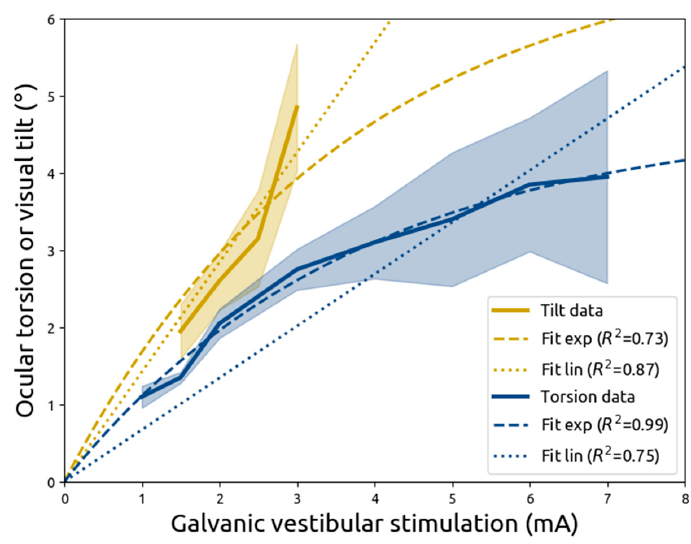
Figure 3. Ocular torsion (blue) and visual tilt (yellow) in degrees ( y -axis) as a function of unipolar direct current galvanic vestibular stimulation ( x -axis). Solid lines represent the average and shading the standard error of the mean in data reported by Zink et al. (1998). Dotted lines represents directly proportional linear fits (Equations (3) and (4)), and dashed lines represent exponential model fits (Equations (5) and (6)).